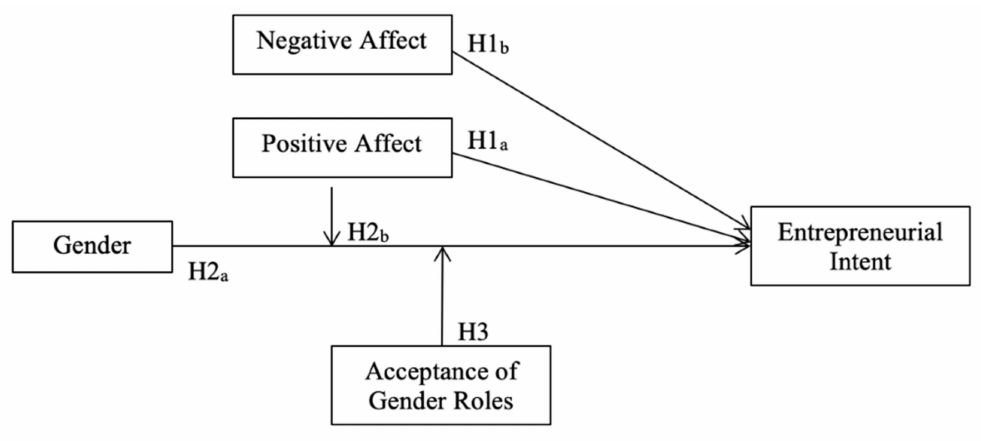
Figure 1. Model of positive and negative a ff ect, gender, gender roles, and entrepreneurial